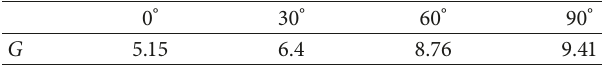
Table 3: Shear modulus of rock mass with different